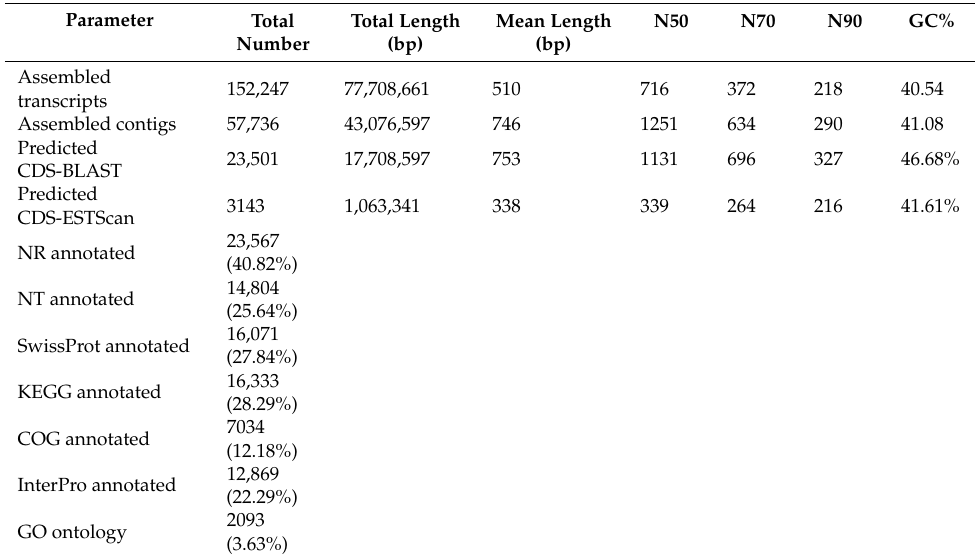
Table 2. Summary of the de novo assembly and annotation metrics of the transcriptome library of B. trigonica .